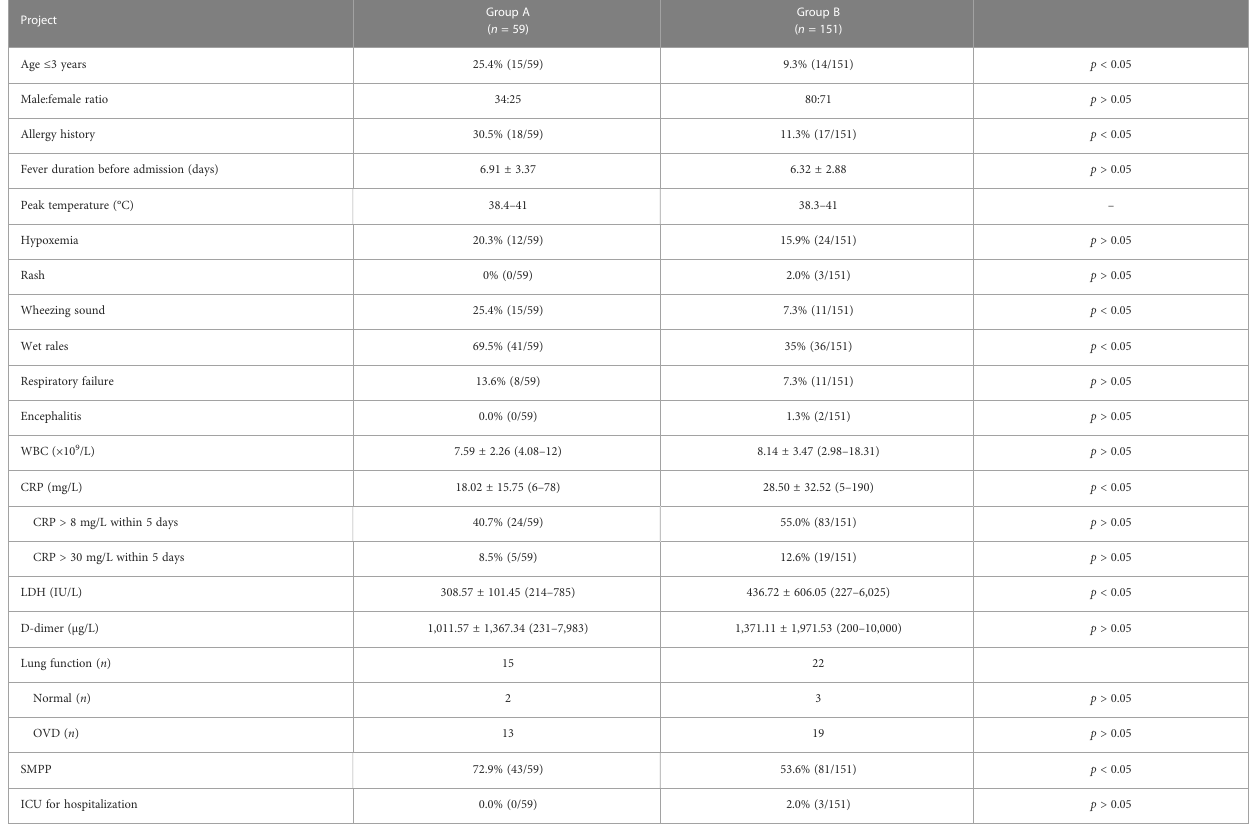
TABLE 1 Clinical characteristics and laboratory data on admission in MPP